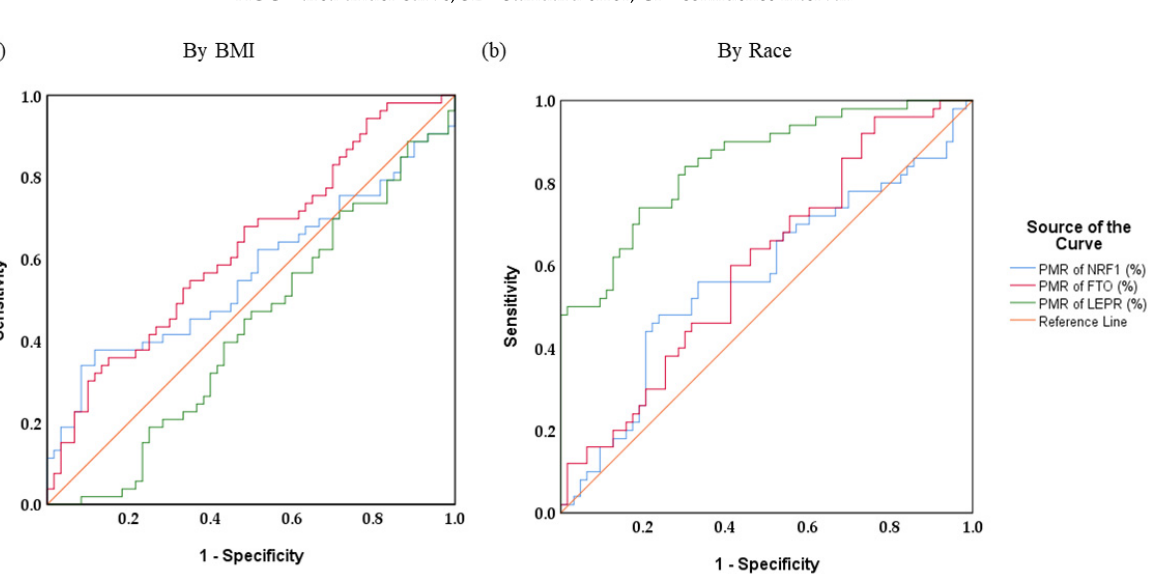
Table 9. ROC curve analysis of methylation of NRF1, FTO, and LEPR with the races shows the relationship between sensitivity and specificity in determining a specific marker.